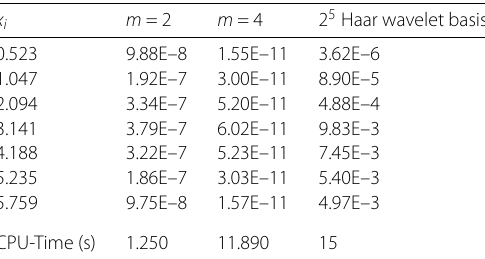
Figure 1 Comparison between the exact and numerical solution for m = 4 of Example 5.1